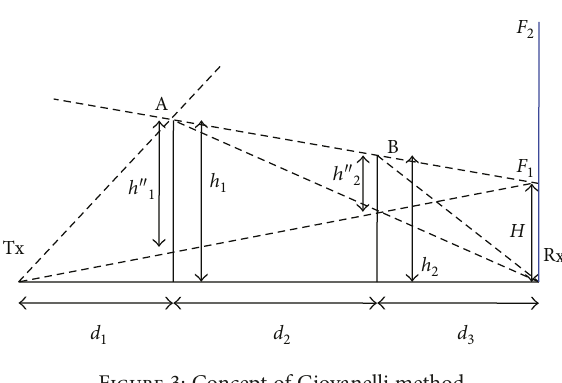
Figure 3: Concept of Giovanelli